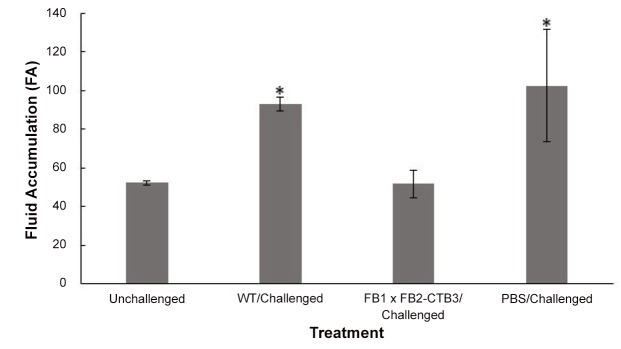
Immunoprotection against CT challenge of BALB/c mice immunized with galls expressing the CTB protein.Mice were immunized with either WT galls or FB1 x FB2-CTB 3 galls, and then challenged with CT. Control groups consisted of an unimmunized mice group challenged with CT (PBS/challenged) and an unimmunized unchallenged mice group (unchallenged). Mice were challenged with 10 μg of CT one week following the last boost. After 6 h of CT toxin administration, mice were sacrificed, and fluid accumulation (FA) was estimated by weighing carcass and small intestines. Comparisons between challenged and unchallenged groups have been made, and significant differences found against the unchallenged group are denoted using an asterisk (P< 0.05). Note the lower FA values in the group immunized with FB1 x FB2-CTB 3 galls.